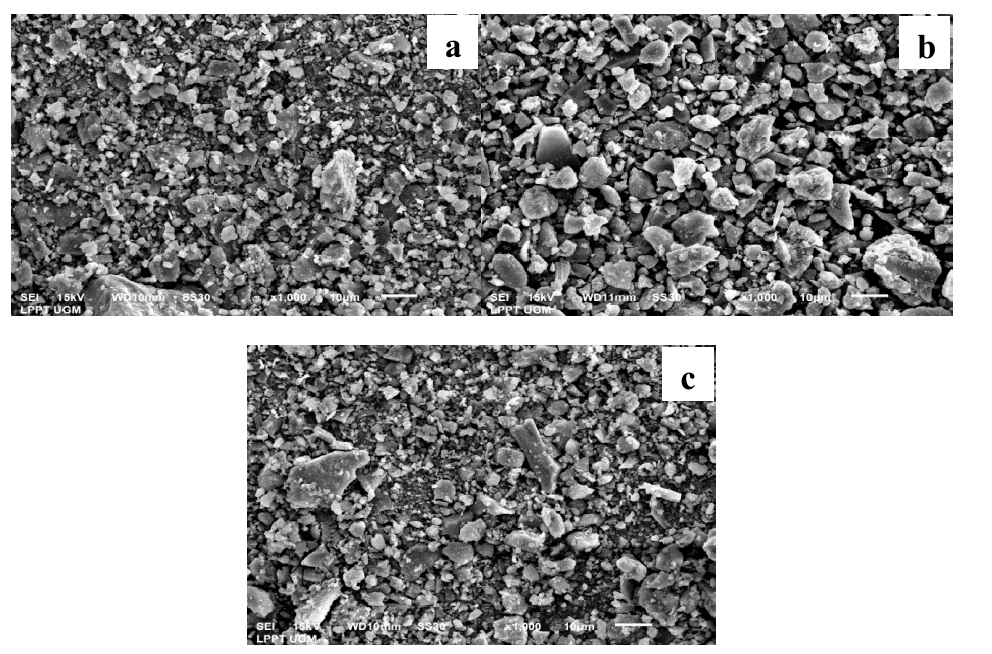
Figure 3. Catalyst surface morphology at 1000× magnification of ( a ) Ni-Z3, ( b ) Ni-Z5, and( c ) Ni-Z7.